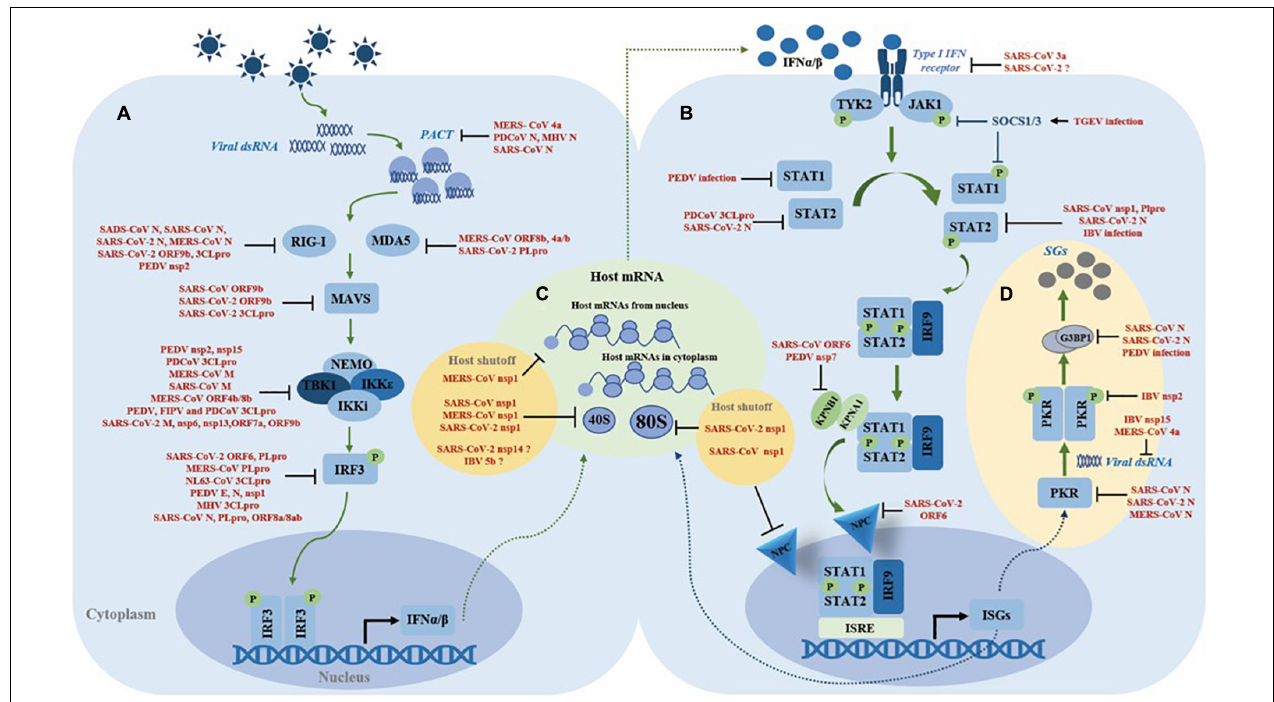
FIGURE 2 | Summary of the mechanisms of coronaviruses antagonizing type I IFN system. (A) Inhibition of IFN induction. (B) Inhibition of the JAK-STAT pathway. (C) Manipulation of the host translation machinery. (D) Regulation of stress granules